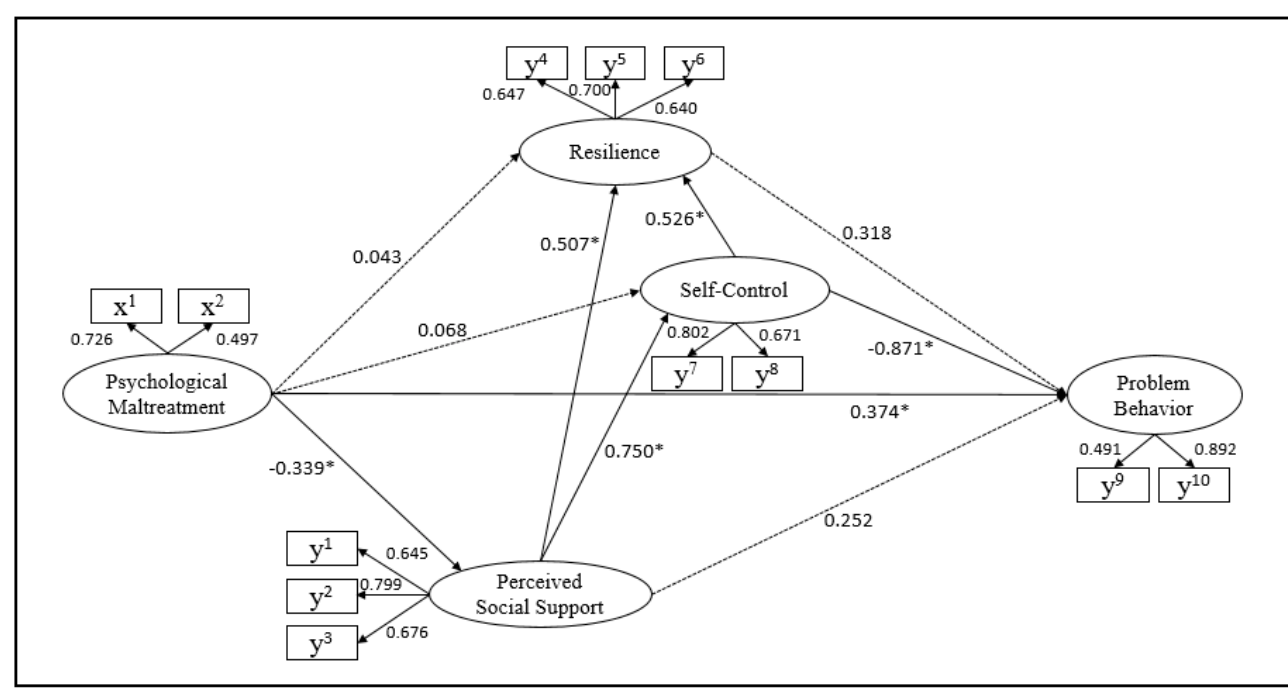
Figure 2. Hypothetical Path Diagram of the Hypothetical Model. x 1 , emotional abuse; x 2 , neglect; y 1 , family; y 2 , friend; y 3 , teacher; y 4 , affirmative; y 5 , controllability; y 6 , sociability; y 7 , long-term control; y 8 , short-term control; y 9 , internalizing; y 10 , externalizing. * p < 0 . 05; ** p < 0 . 001.